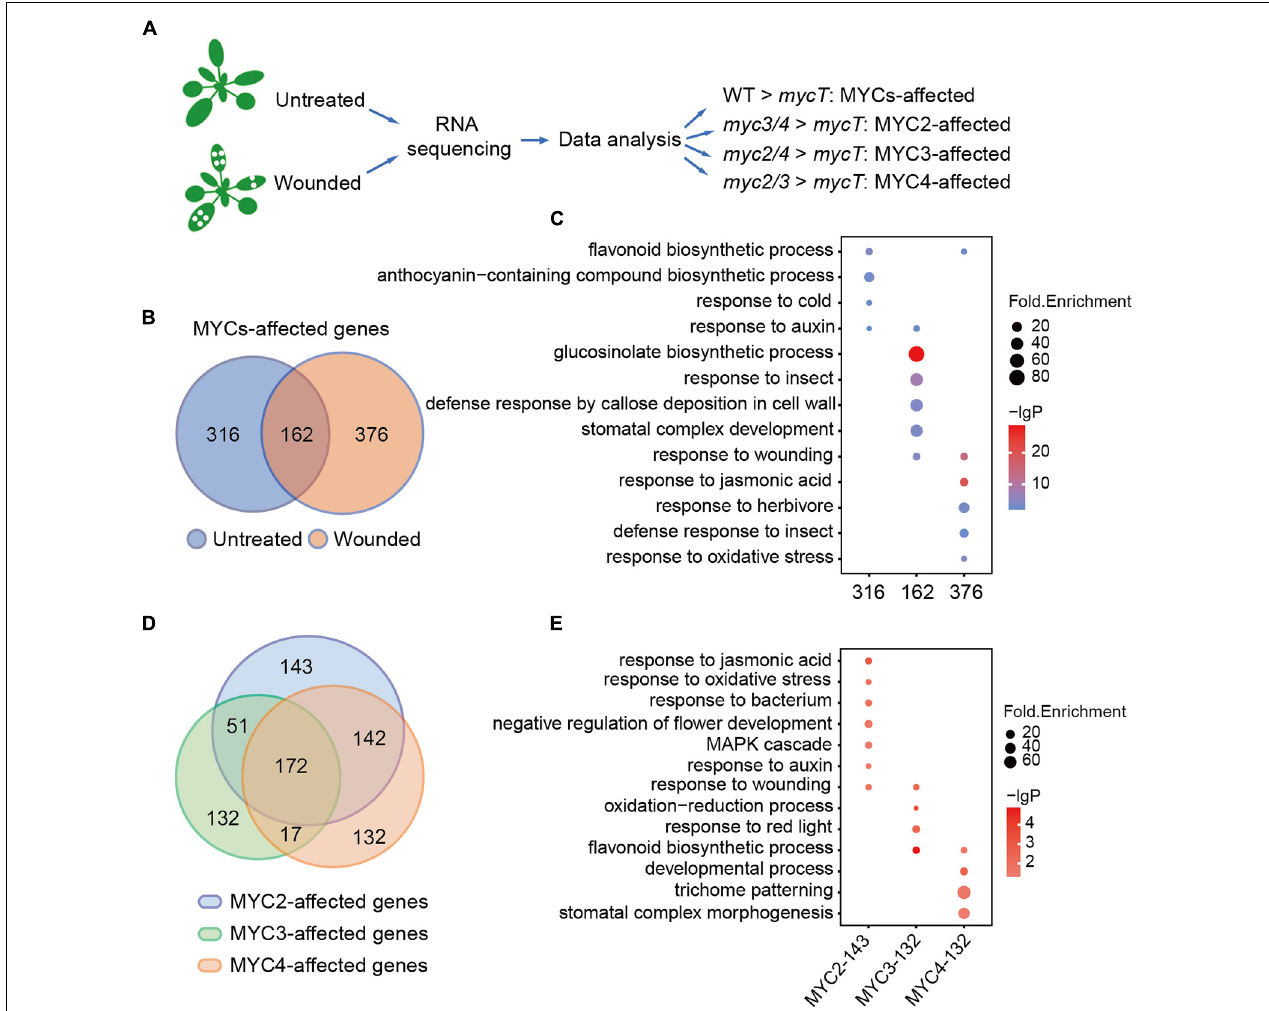
FIGURE 2 | MYC2, MYC3, and MYC4 have different contributions in biological processes. (A) Workflow of sample collection, sequencing, and analysis. The untreated plants and the plants 4 h post wounding were collected and used for RNA sequencing and data analysis. (B) Venn diagram shows MYC-affected genes in the plants with (orange and wounded) or without (blue and untreated) wounding treatment. (C) GO enrichment analysis of 316, 162, and 376 MYC-affected genes as described in panel (B) . (D) Venn diagram of MYC2-, MYC3-, and MYC4-affected genes in either untreated or wounded plants, which were described in Supplementary Figure 2A . (E) GO analysis of genes only affected by MYC2, MYC3, and MYC4, respectively. (C,E) The size of the dot represents fold enrichment, and color stands for –lg( P